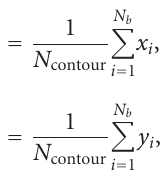
Figure 7: Interactive selection of the feature